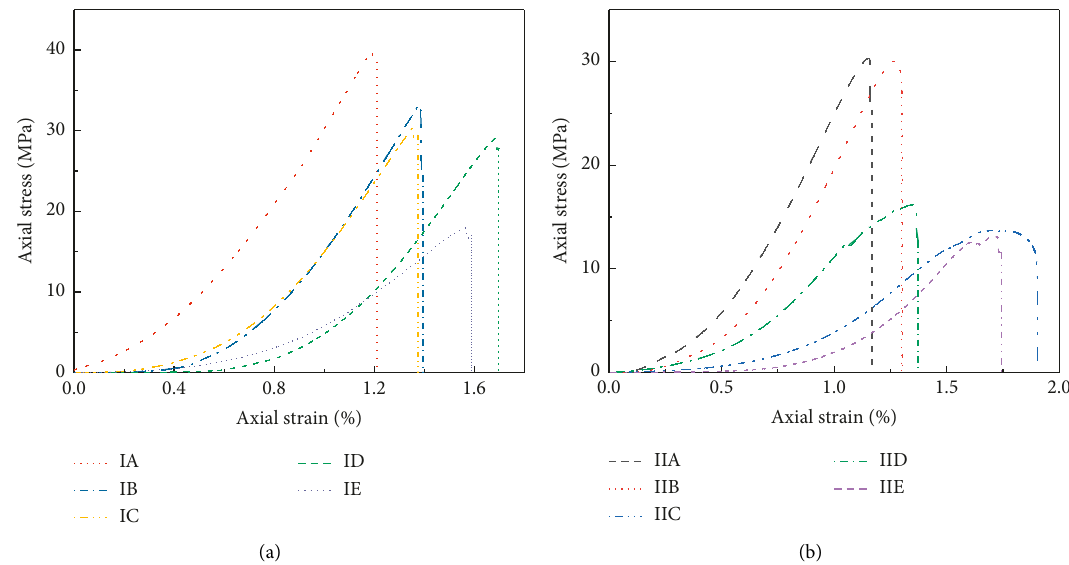
Figure 3: Stress-strain relationship of sandstone with different F-T cycles. (a) Dry sandstone. (b) Saturated sandstone.